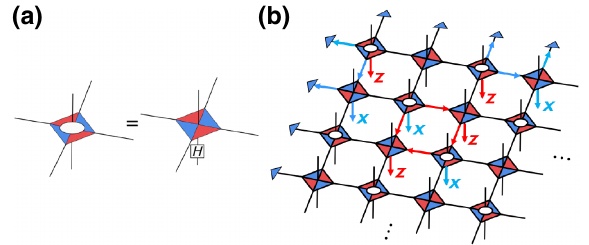
FIG. 19. (a) The locally modified tensor by a Hadamard. (b) A sample XZZX code tensor network where the boundary is con- tracted with X stopper tensors. Some stabilizer generators are marked using operator